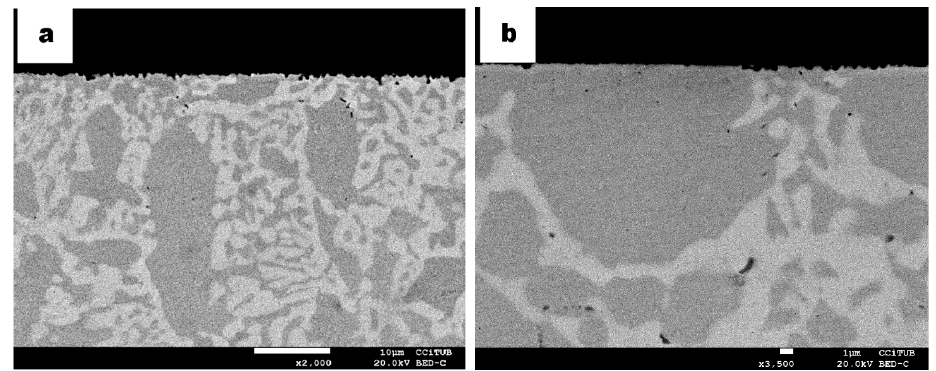
Figure 3. BSE micrograph of DSS carburized samples, ( a ) showing γ (grey phase) and ferrite δ (greyer phase) as well as sigma σ (bright phase). ( b ) Higher magnification of a region away from the surface; some dark points are identified as chromium carbides (dark phase).